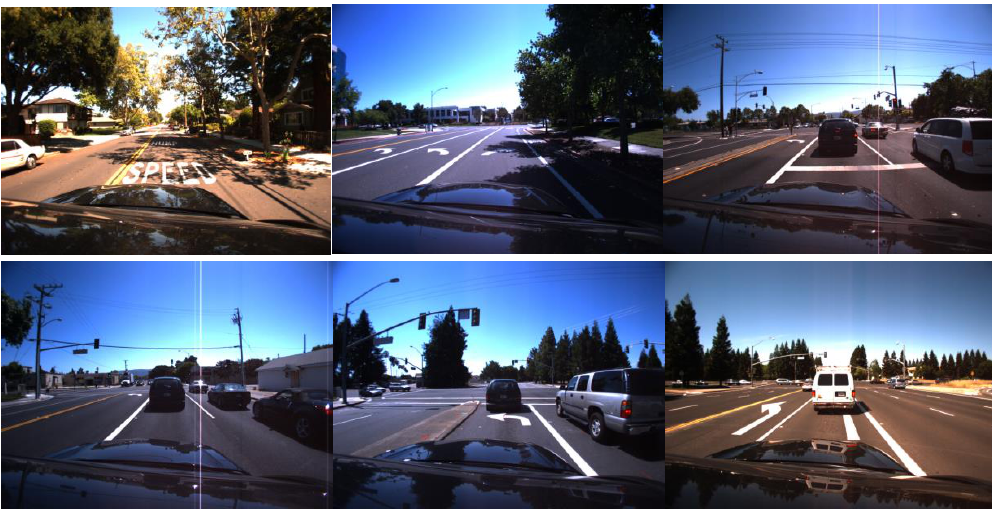
Figure 19. Examples of the Road Marking dataset.